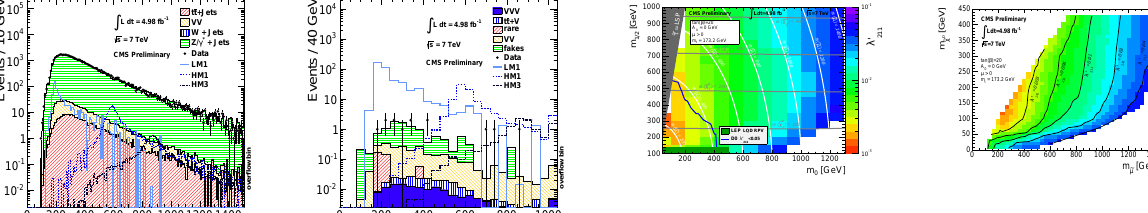
Table 1. Event yields with systematic uncertainties after selection requirements, broken down in individual Standard Model background contributions, with observed 95% C.L. limits on the number of signal events N si g in total and for each signal region.